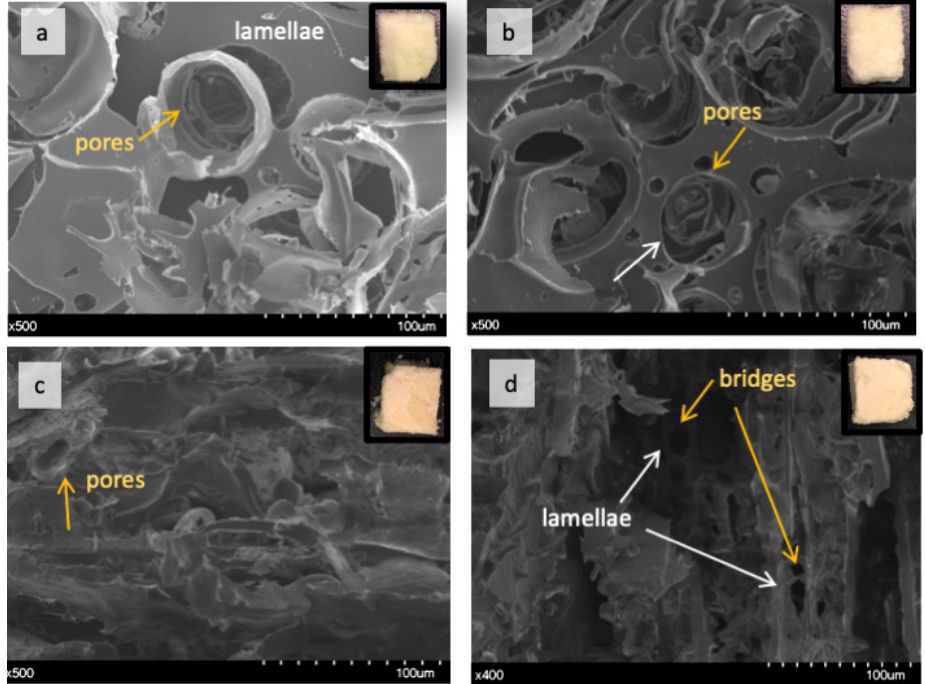
Figure 5. SEM micrographs of lupin foams (ca. 1 cm 3 ). ( a ): LPI-0-0; ( b ): LPI-0-SB6; ( c ): LPI-LA-SB6; ( d ):